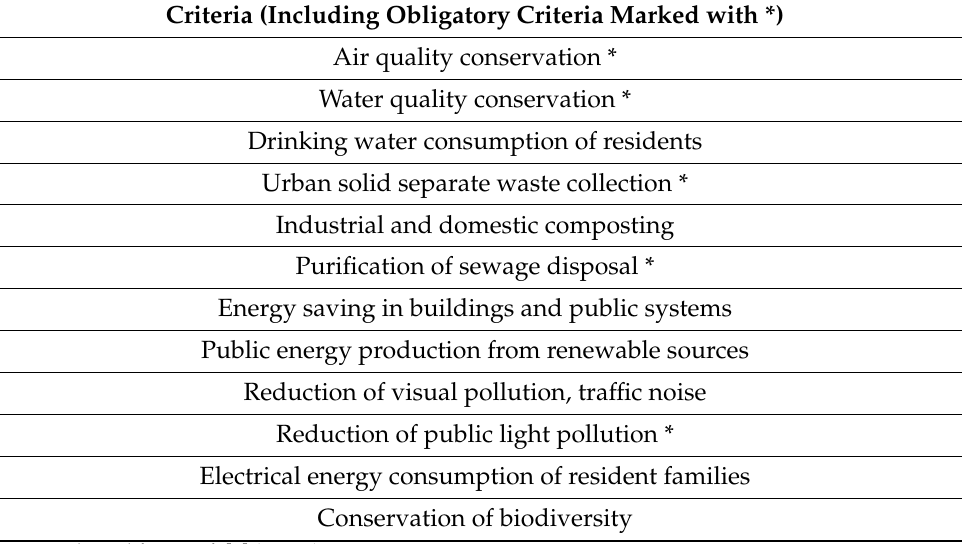
Table 1. Criteria used to assess cities in the area of “energy and environmental policy”. Criteria (Including Obligatory Criteria Marked with